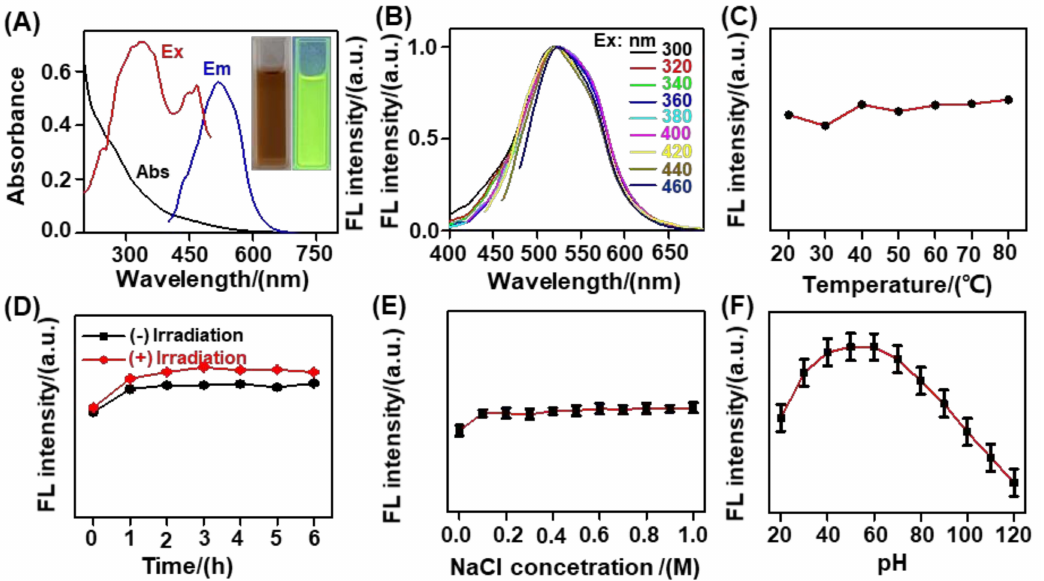
Figure 3. Optical features of biomass − based C − dots. ( A ) Absorption, excitation, and fluorescence emission spectra of biomass − based C − dots in D.I. water. Inset is a photograph and fluorescence image in D.I. water under a 365 nm UV lamp. ( B ) Fluorescence emission spectra of biomass − based C − dots in D.I. water upon excitation at varying wavelengths. ( C ) Normalized fluorescence intensity of biomass-based C − dots incubated at varying temperatures in D.I. water. ( D ) Normalized fluores- cence intensities of biomass-based C − dots in D.I. water without ( − ) and with (+) LED irradiation for varying times. ( E ) Normalized fluorescence intensity of biomass − based C − dots in varying concentrations of NaCl solution. ( F ) Normalized fluorescence intensity of biomass-based C − dots in BR buffer at varying pH